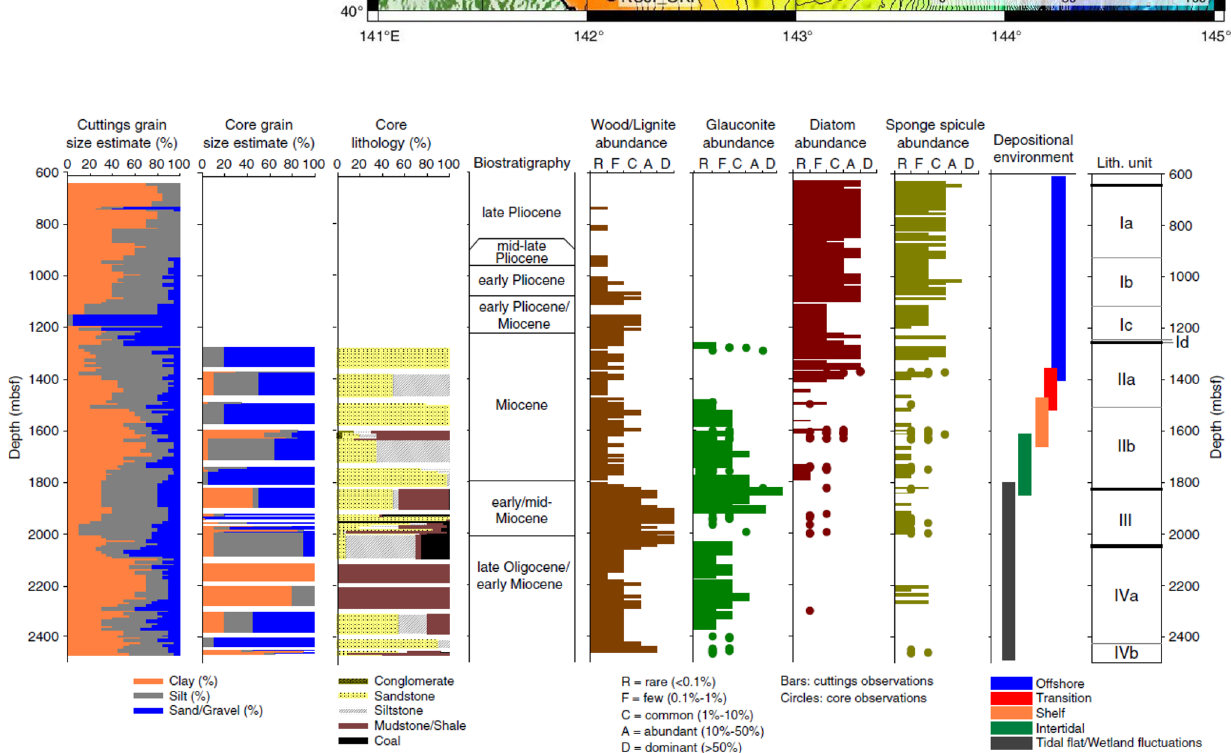
Fig. 3 Lithostratigraphic units of Field Y . source Inagaki F, Hinrichs KU, Kubo Y. (2013). Expedition 337 summary, Expedition 337 Scientists, Proc. IODP | Volume 337. https